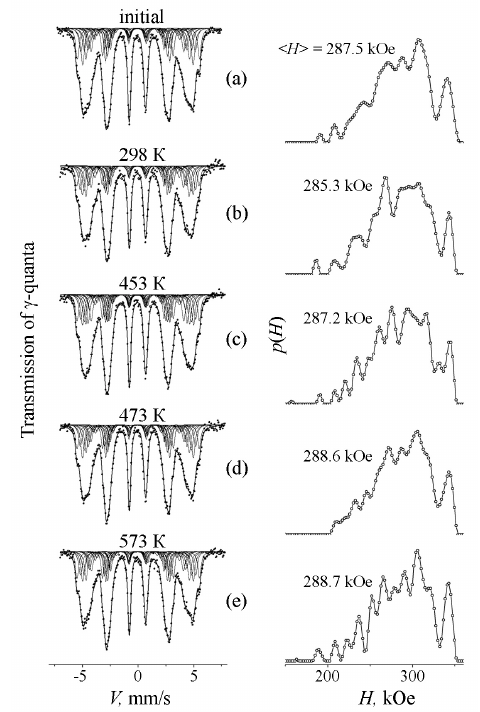
Figure 3. Mössbauer spectra, distributions p ( H ), and values of < H > for the alloy Fe ‐ 16Cr ‐ Au in the initial state and after HPT ( ε = 5.9, n = 3 rev.) at different temperatures: ( a )—initial state (annealed at 1073 K, 4 h); ( b )—HPT at 298 K; ( c )—HPT at 453 K; ( d )—HPT at 473 K, and ( e )—HPT at 573 K. Mössbauer spectra were measured at room